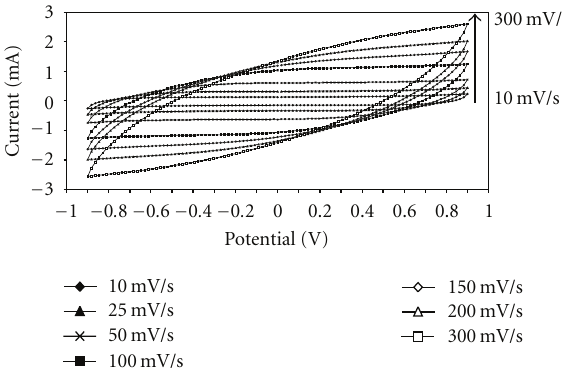
Figure 7: E ff ect of scan rates on the shape of cyclic voltammograms. Only the 50th cycle of each cyclic voltammogram is